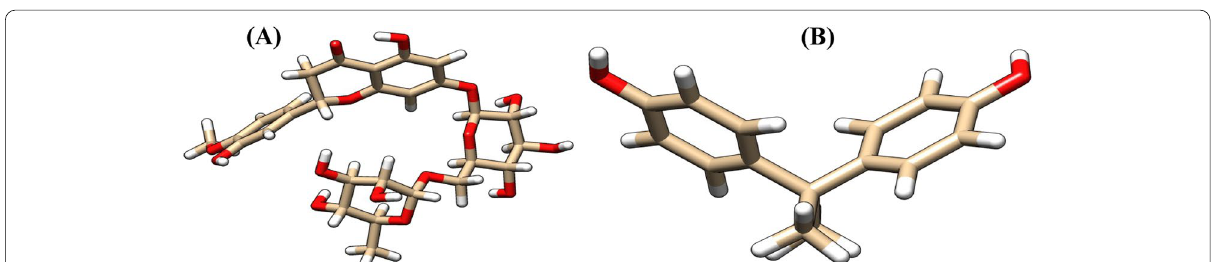
Fig. 2 Three-dimensional structures of (A) hesperidin and (B) bisphenol